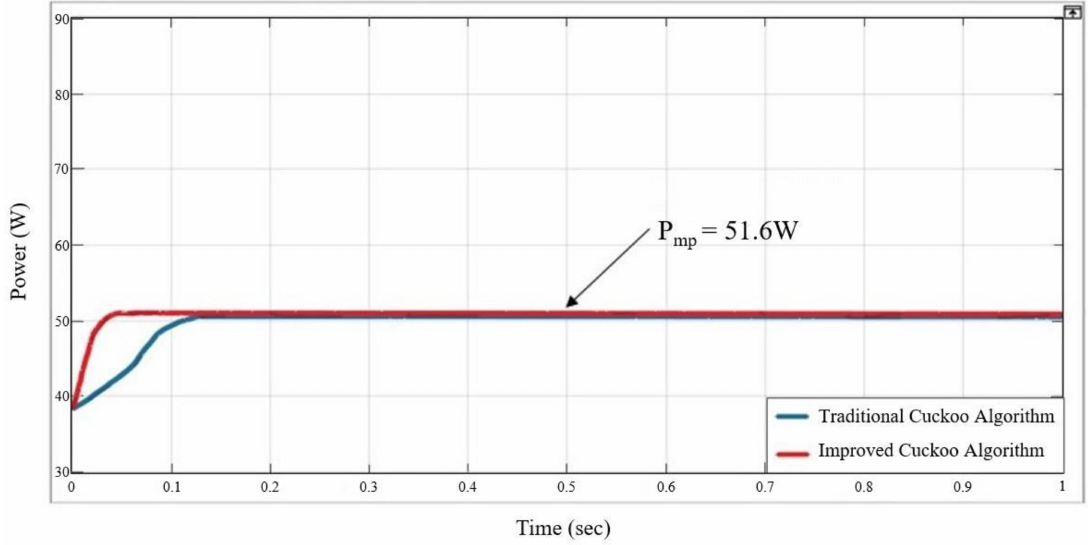
Figure 13. Simulation result of maximum power point tracking of traditional and improved cuckoo algorithm in Case